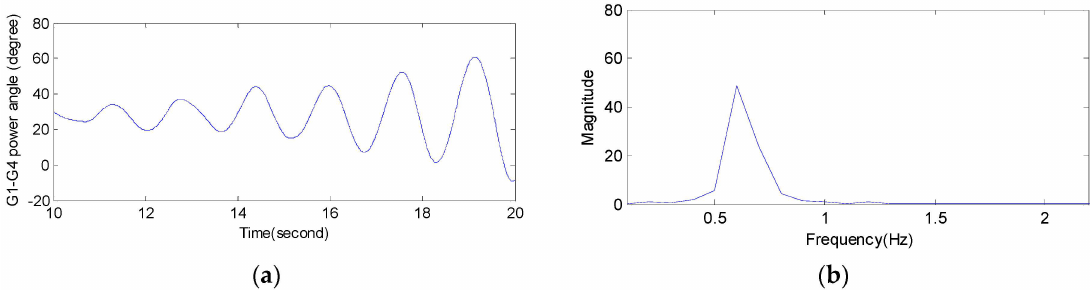
Figure 2. The resonance property of the LFO signal. ( a ) Power angle oscillation waveform of G4 relative to G1; ( b ) FFT frequency spectrum.